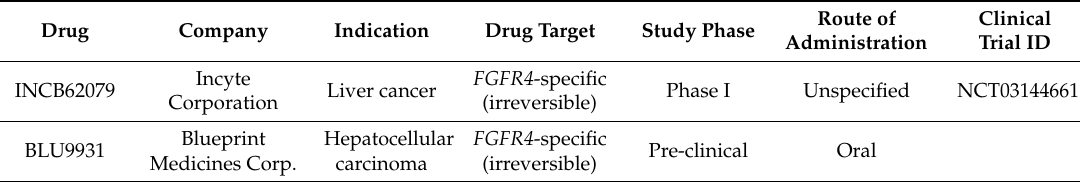
Table 3. FGFR4 -specific irreversible inhibitors under di ff erent phases of clinical